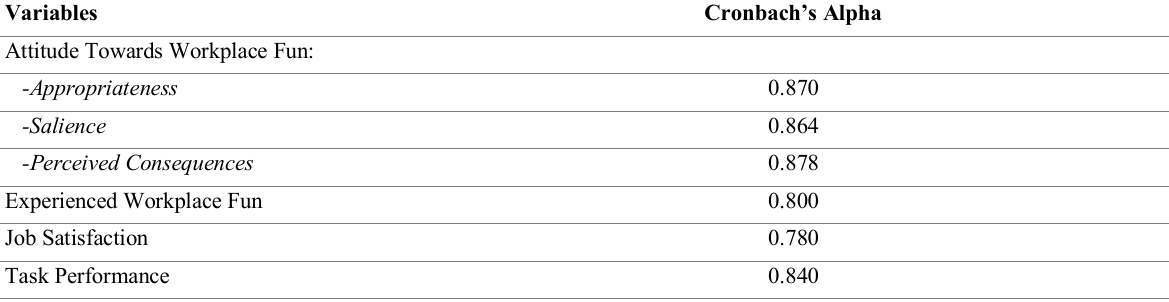
Table 1: Reliability